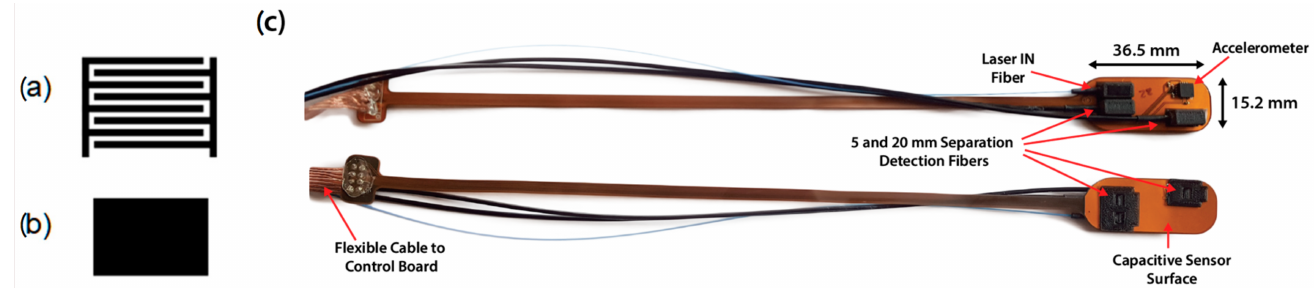
Figure 1. ( a ) Drawing of an interdigitated comb electrode (V1). Two comb-shaped electrically conductive electrodes are placed in an interdigitated fashion and each comb finger acts as a plate of a mutual planar capacitor with the adjacent fingers. ( b ) Drawing of a self-capacitance single electrode (V2), where an isolated copper plate acts as a plate of a planar capacitor. ( c ) Pictures of the probe flexible printed circuit board (PCB) equipped with the single-electrode contact sensor. Top—Probe top view: the accelerometer Integrated Circuit (IC) and the 3D-printed fiber holders, not in contact with the subject’s skin. Bottom—Probe bottom view: a copper plane covering the whole bottom layer of the PCB acts as single sensing electrode for the contact